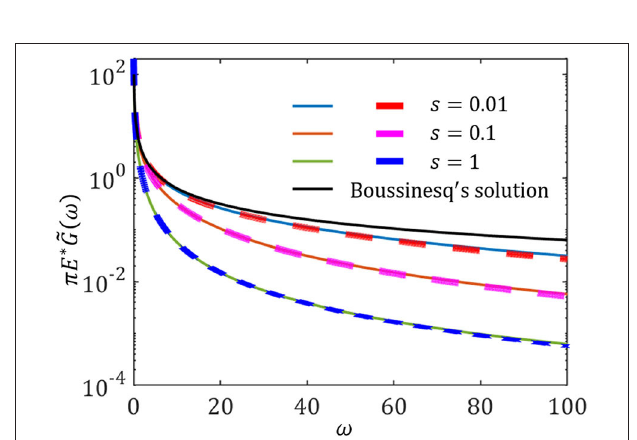
FIGURE 2 | The fundamental solutions in Fourier space with different values of s . Thick dashed lines are the numerical results of the FFT of Equation (2), and thin solid lines are the theoretical predictions of Equation (3). Note the unit of s is same as 1 /ω